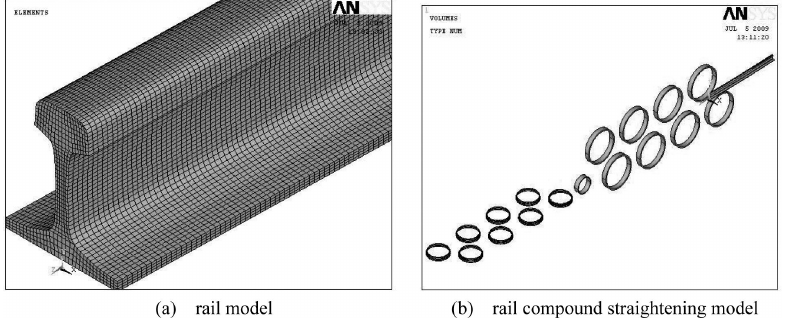
Fig. 3. The rail compound straightening FEM model.